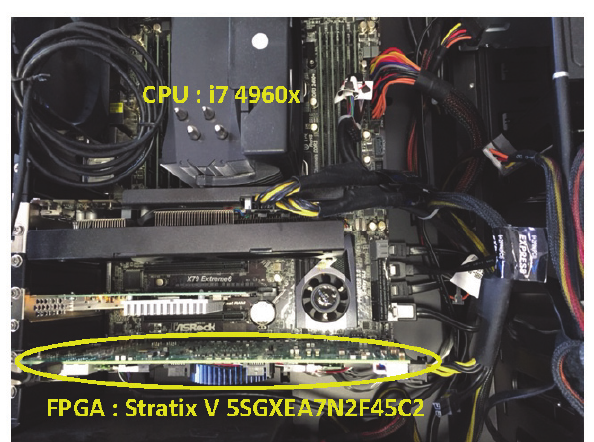
Fig. 10. The implemented heterogeneous system with a CPU and an FPGA.